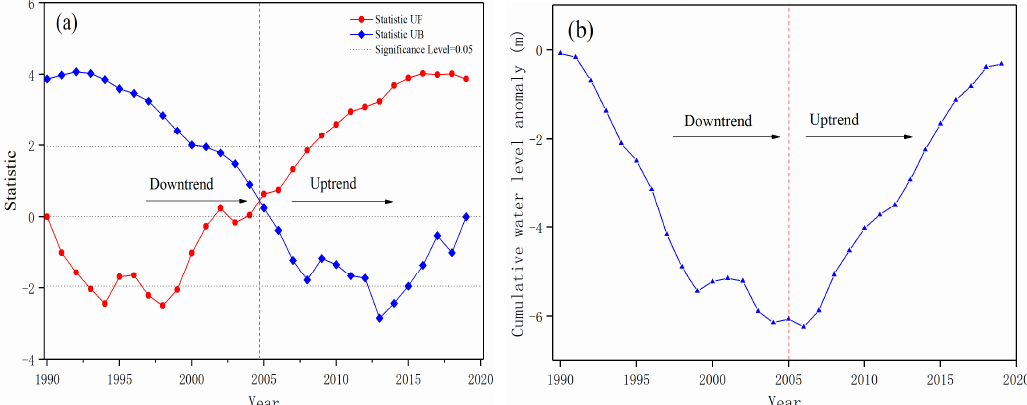
Figure 6. Detection of abrupt changes and variation trend of annual average water level in Erhai Lake (EL) from the perspective of the M-K method ( a ) and cumulative anomaly method ( b ). If the cumulative anomaly curve shows an upward trend, it indicates that the cumulative anomaly value increases and the discrete data are greater than the mean value; on the contrary, the inflection point indicated that it is less than the mean value. The inflection point of the trend is the mutation point.